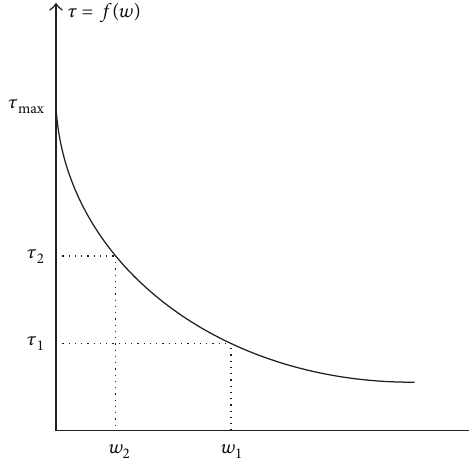
Figure 5: Opportunistic carrier